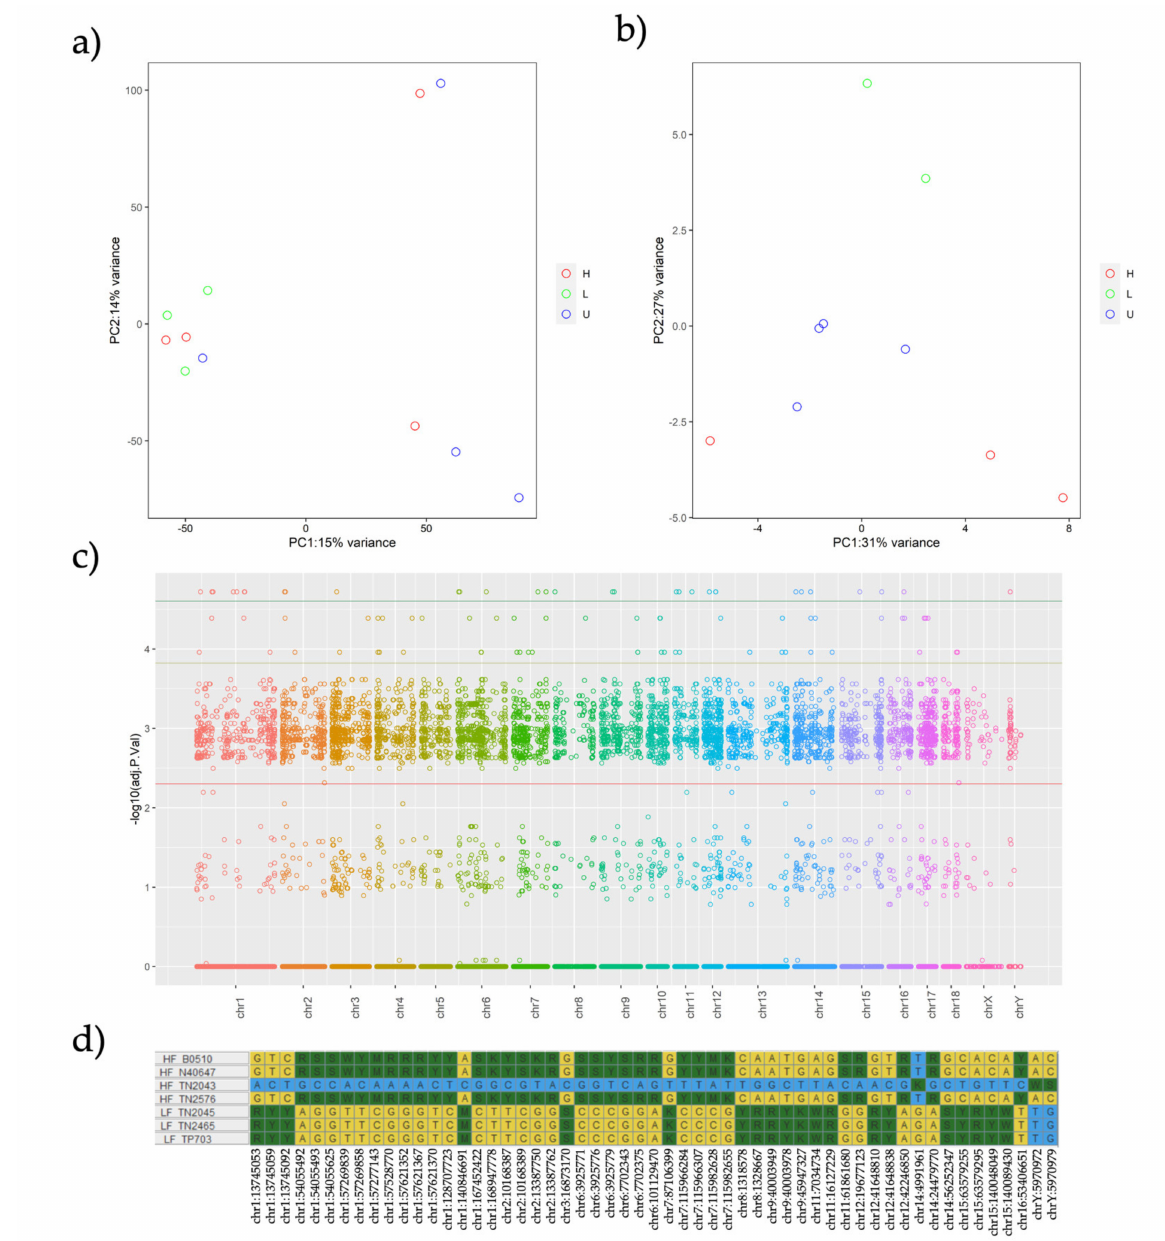
Figure 1. ( a – d ). Principal Component Analysis (PCA) across 11 individual boars from High Fertile (HF), Low Fertile (LF), and Unknown Fertility (UF) experimental groups depicting in ( a ) all 42,963 Single Nucleotide Polymorphisms (SNPs) and in ( b ) the significant 169 SNPs; ( c ) is a Manhattan plot of all the analyzed SNPs with the green threshold separating the TOP SNPs from the others. Finally, ( d ) lists the loci frequency of these TOP SNPs among all the analyzed